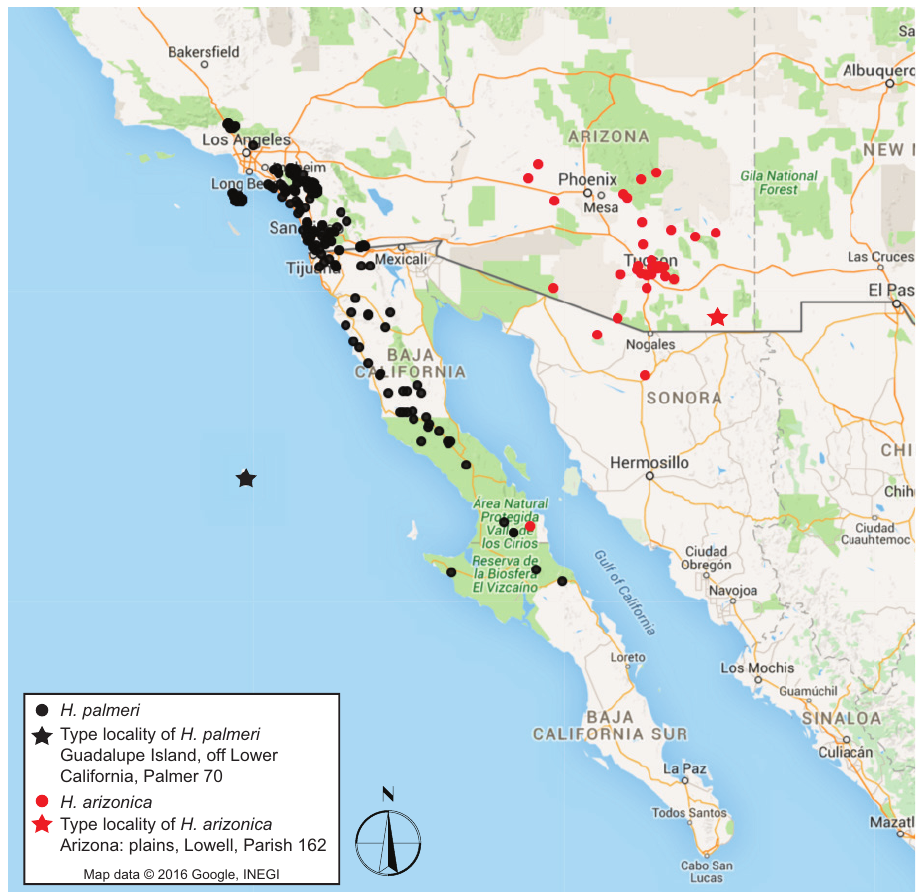
Figure 1. Map of western North America showing Harpagonella collections in major herbaria based on available specimen data from GBIF and Bajaflora. Type collection localities are indicated with black star for H. palmeri and a red star for H. arizonica